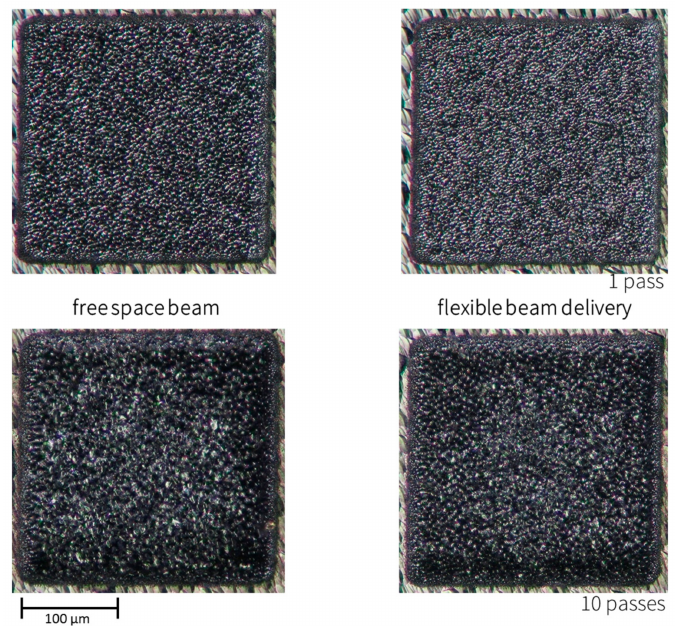
Figure 9. Comparison of surface modification on polychristalline silicon. A single pass of the laser over the area is shown at the top and 10 consecutive passes are shown at the bottom. Free-space beam delivery on the left and fiber beam delivery on the right (in cooperation with Laserzentrum Hannover).